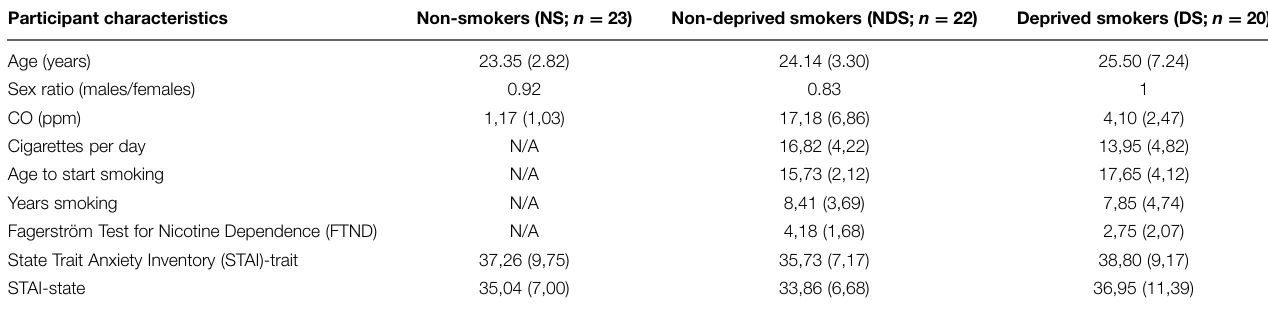
TABLE 1 | Sample characteristics and means scores (and standard deviations) of questionnaires. Participant